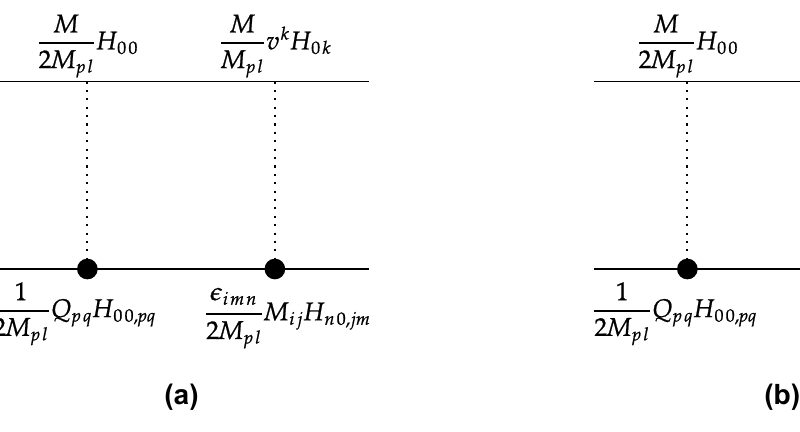
Figure 10 . Leading Order of Q and M